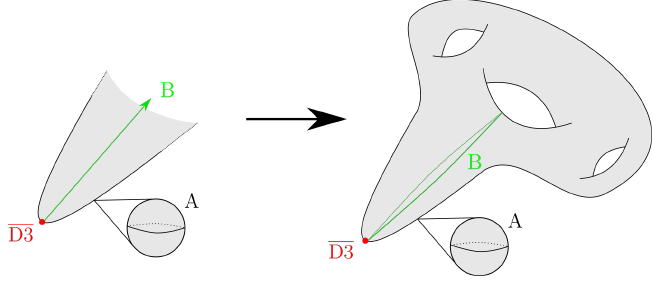
Figure 4 . The KS throat and its